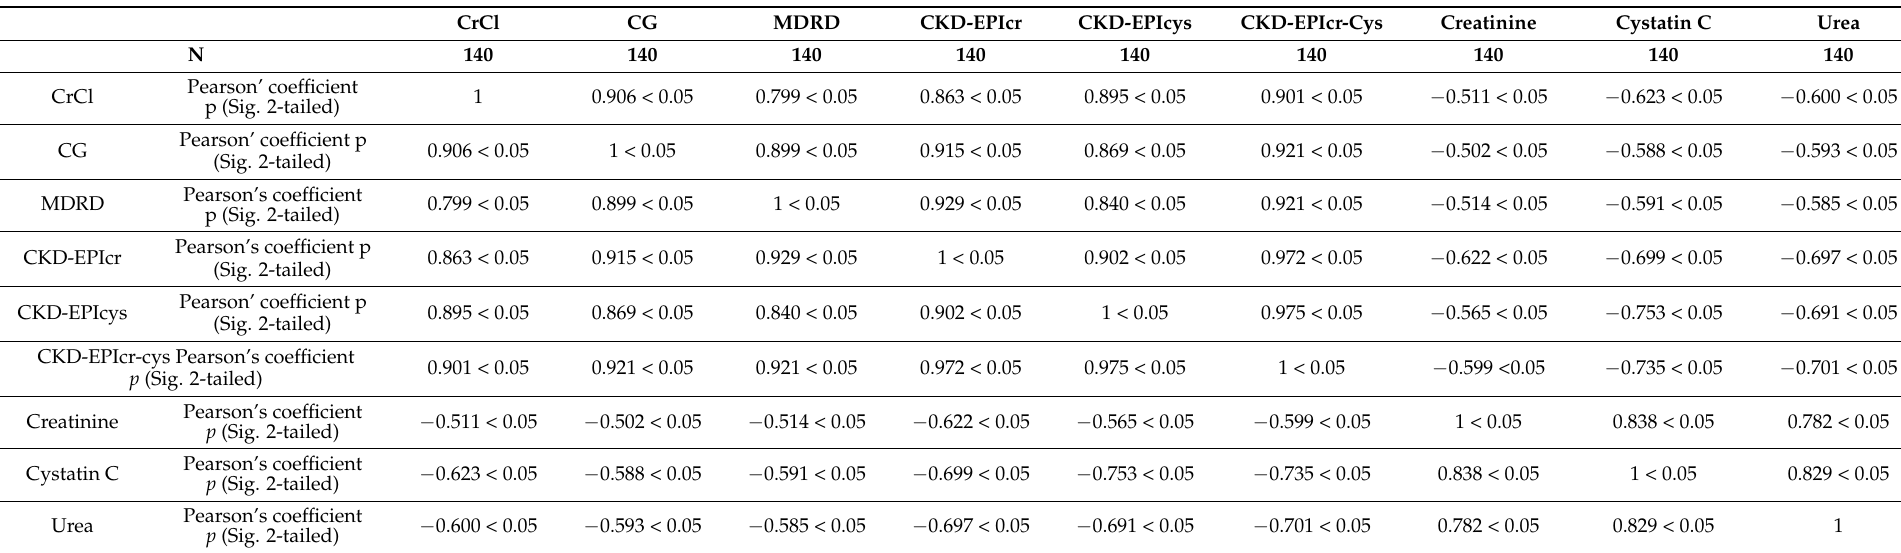
Table 1. Correlation of methods of eGFR and clinical